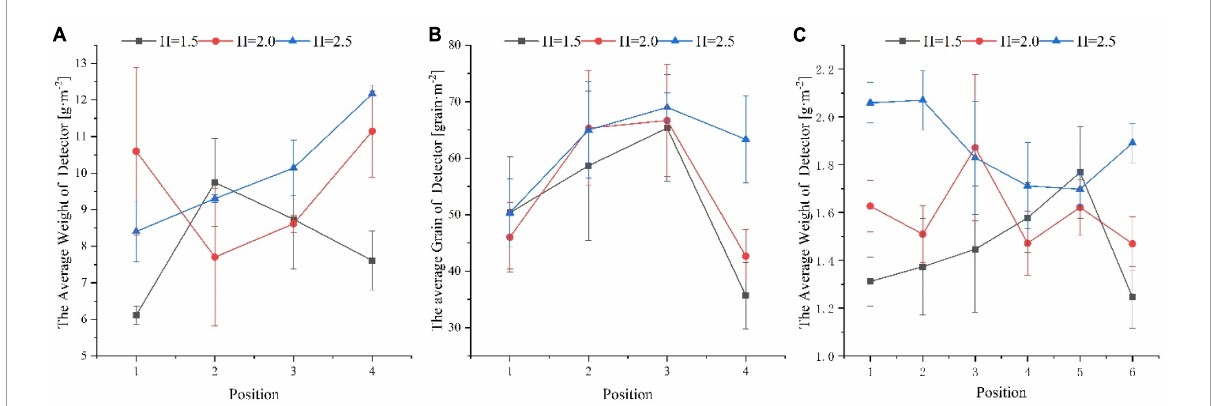
FIGURE10 The uniformity of spreading in the horizontal direction at different heights. (A) Represents uniformity of horizontal distribution of sown seeds. (B) Represents uniformity of horizontal distribution of fertilizer in square collectors. (C) Represents uniformity of horizontal distribution of fertilizer in circular collectors. In all figures, the horizontal coordinates indicate the collector number, and the vertical coordinates indicate the distribution, where “h” indicates the flight height of the mUAV from the ground.